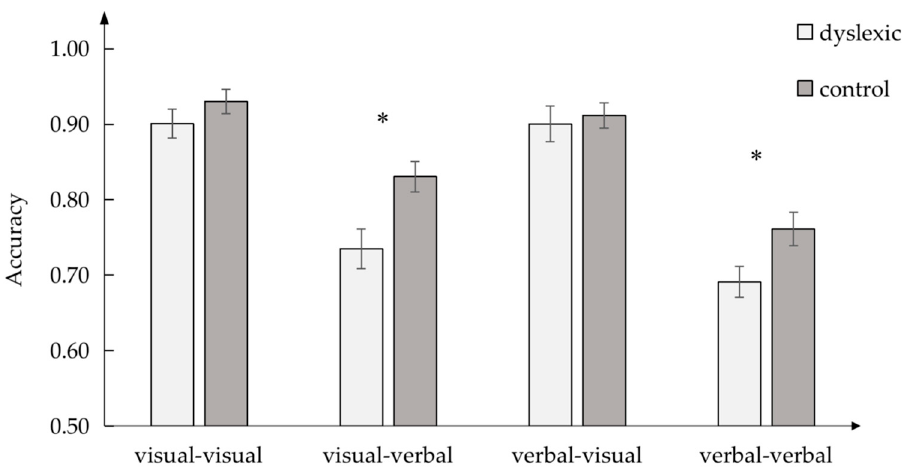
Figure 5. A trial in the priming task.